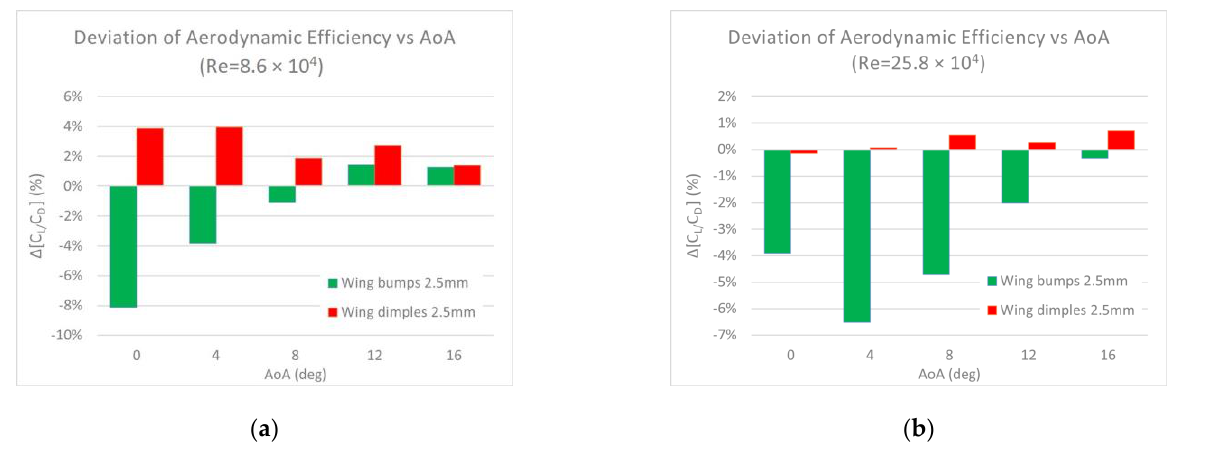
Figure 12. Deviation of the aerodynamic efficiency of the wings with dimples and bumps compared to the original wing under ( a ) Re = 86,000 and ( b ) Re = 258,000.